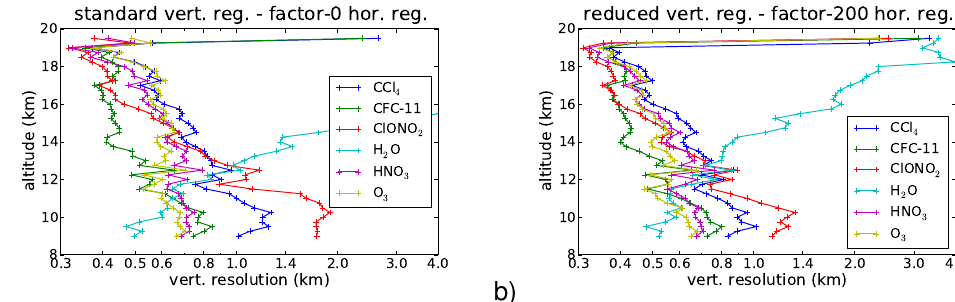
Fig. 11. Two cross-sections of CFC-11 (a) and ClONO 2 (b) volume mixing ratios for a reduced vertical regularisation strength and factor-200 horizontal regularisation.